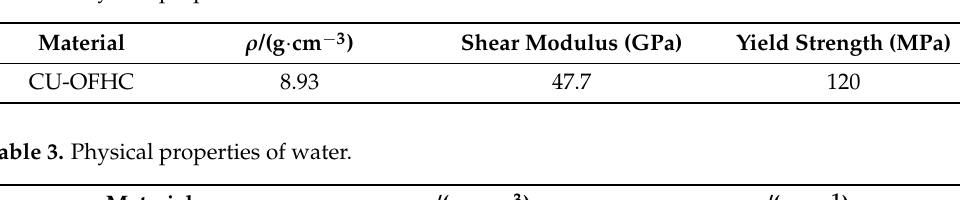
Table 2. Physical properties of CU-OFHC.